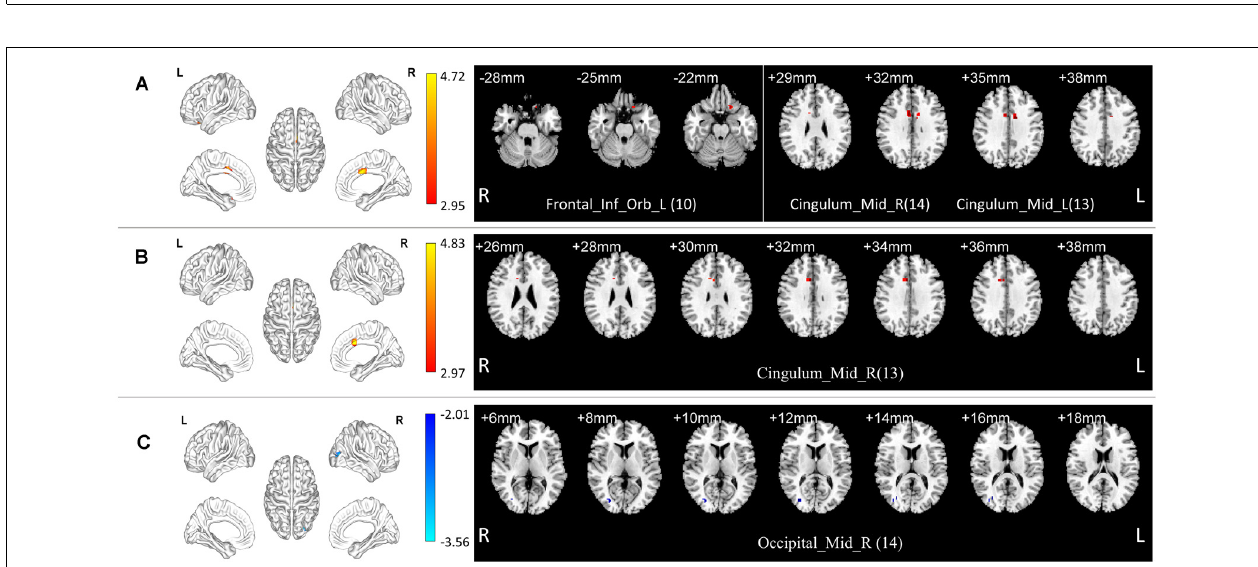
FIGURE 1 | Local functional change pattern of Obj-SCD group. The Obj-SCD group compared with the HC group. (A) In the normal band, fALFF increased in the left orbital part of inferior frontal gyrus, the right middle occipital gyrus, cerebellar vermis; decreased fALFF in the left inferior temporal gyrus (Two-tailed t -test; FDR p < 0.017, k > 10 voxels). (B) In the slow-4 band, fALFF increased in the left median cingulate and paracingulate gyri; decreased in the left inferior temporal gyrus and the left precuneus (Two-tailed t -test; FDR p < 0.017, k > 10 voxels). (C) In the slow-5 band, fALFF increased in the right middle occipital gyrus, caudate nucleus, and cerebellar vermis (Two-tailed t -test; FDR p < 0.017, k > 10 voxels). The numbers in brackets are voxels of significant clusters. Labels of significant clusters are defined with the AAL (Anatomical Automatic Labeling) atlas. Abbreviations: Obj-SCD, objectively-defined subtle cognitive decline; fALFF, low-frequency fluctuation amplitude (ALFF); HC, healthy control; FDR, false discovery rate.